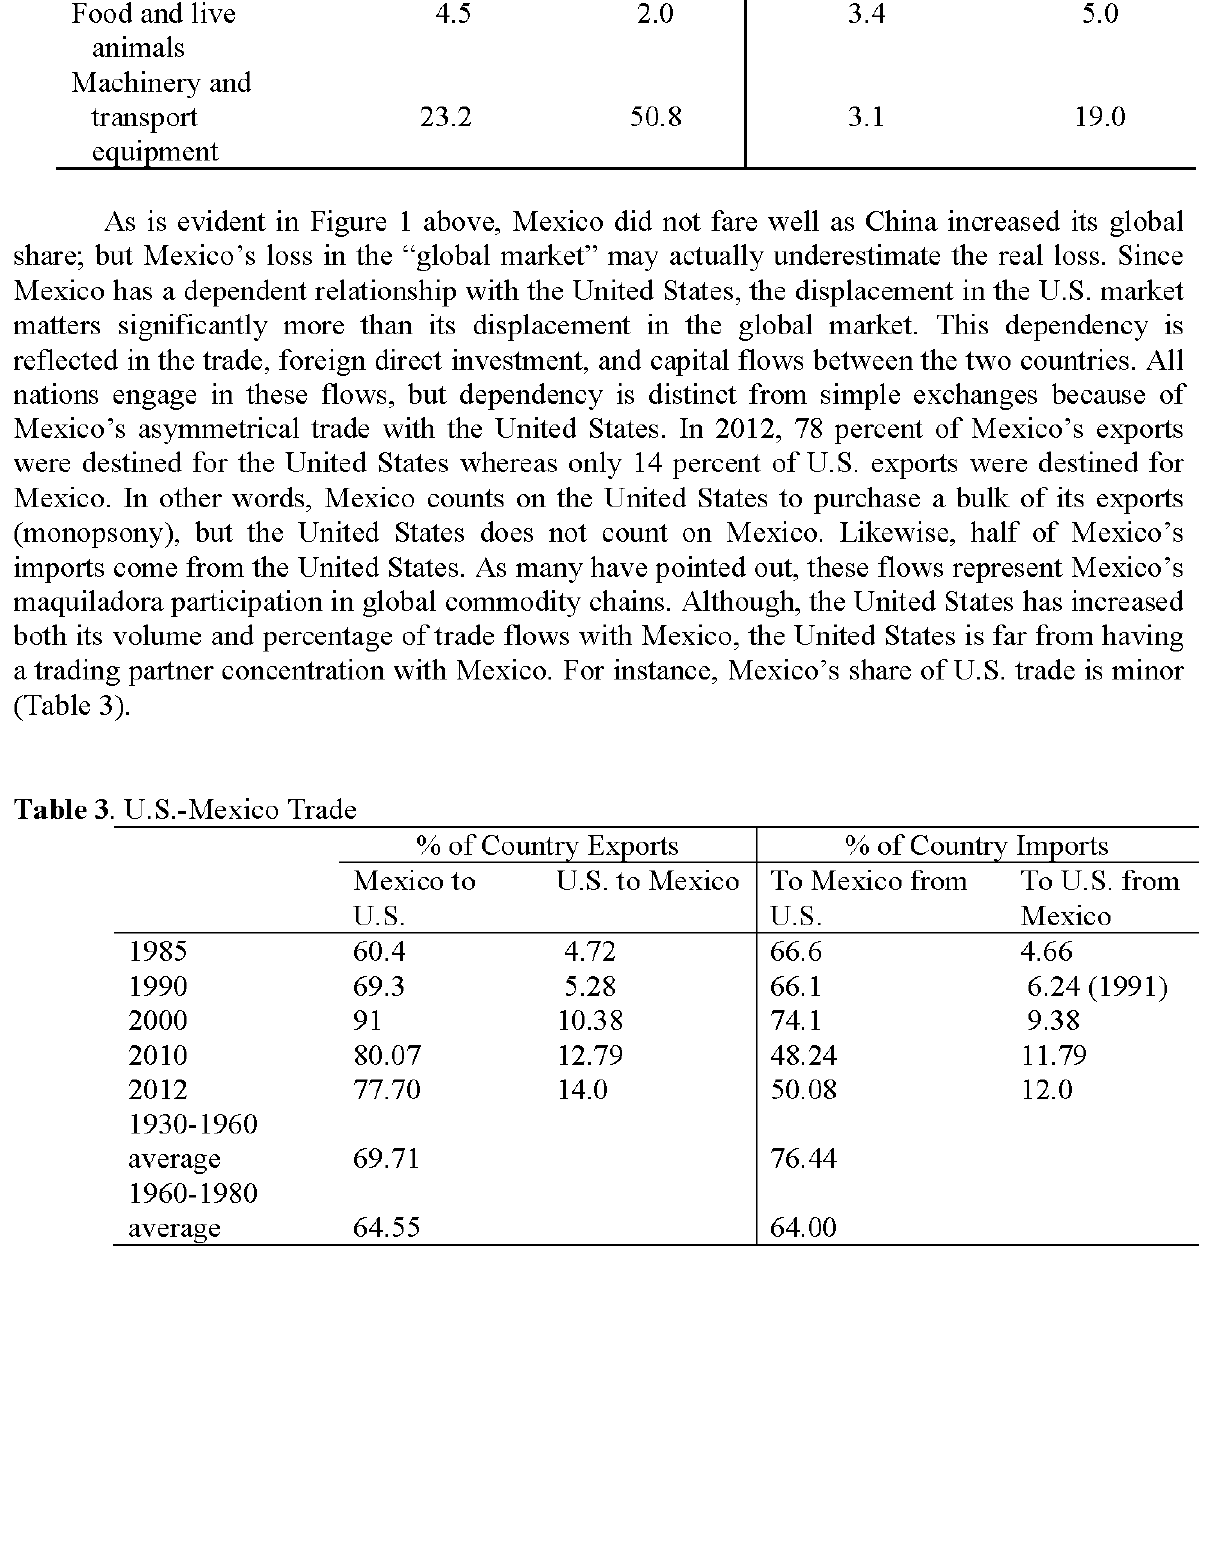
Table 2. China's Ex ort Profile Composition of Chinese Exports Food and live